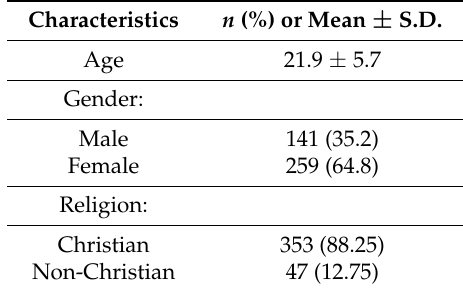
Table 1. Demographic characteristics of the 400 undergraduate students enrolled in the study.